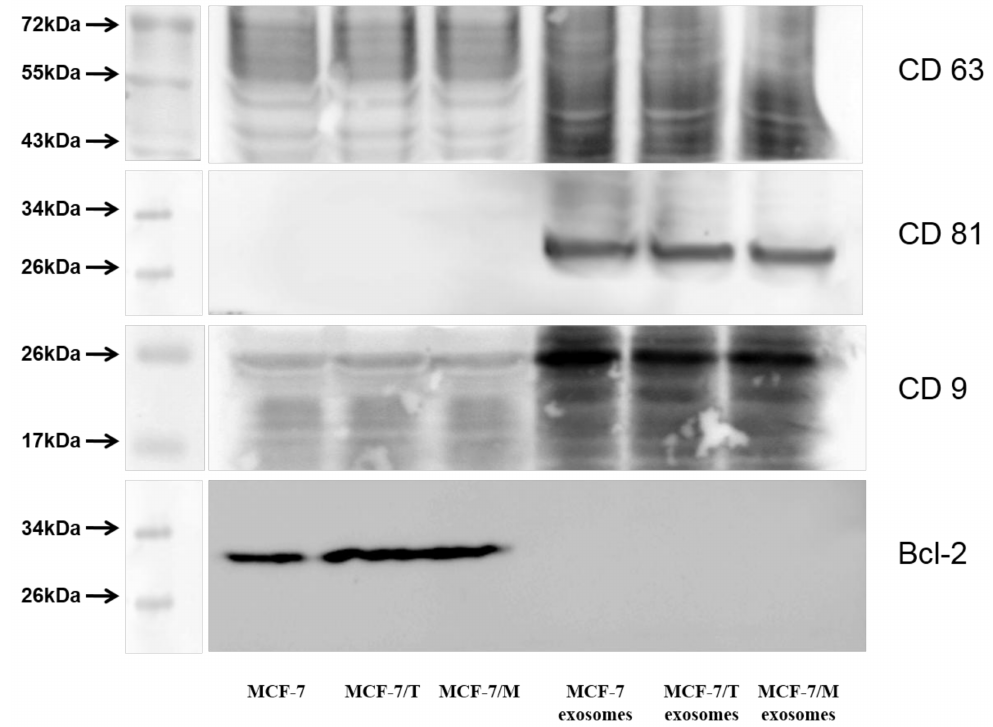
Figure 4. Immunoblotting of exosomal markers CD9, CD63, CD81 in the exosome samples from MCF-7, MCF-7/T and MCF-7/M cells versus cell lines MCF-7, MCF-7/T and MCF-7/M. As a non-exosomal marker was chosen Bcl-2 protein. The blot represents the results of one of the three similar experiments. The western blot analysis of exosome samples versus cell included non-reducing condition and a sample buffer did not contain β